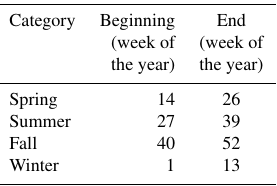
Table B3. Categories of time of occurrence of the flood for the French flood damage functions.